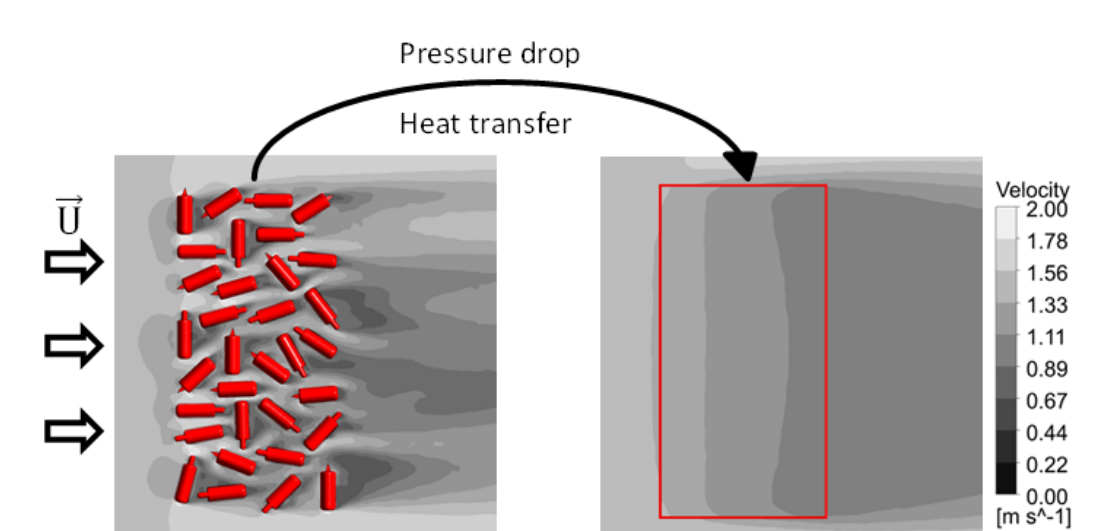
Figure 5. Description of the principle of the cows’ ( left ) replacement by porous medium ( right ) in terms of the pressure drop and heat transfer. The velocity contour evaluated in the horizontal plane of height H AOZ /2.